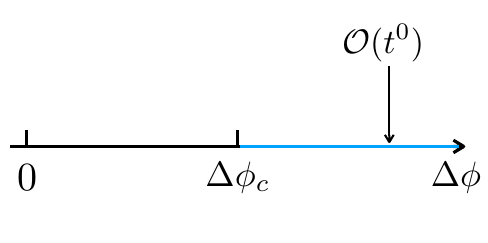
Figure 32 . The leading time evolution of the pseudo entropy in the large ∆ φ phase.